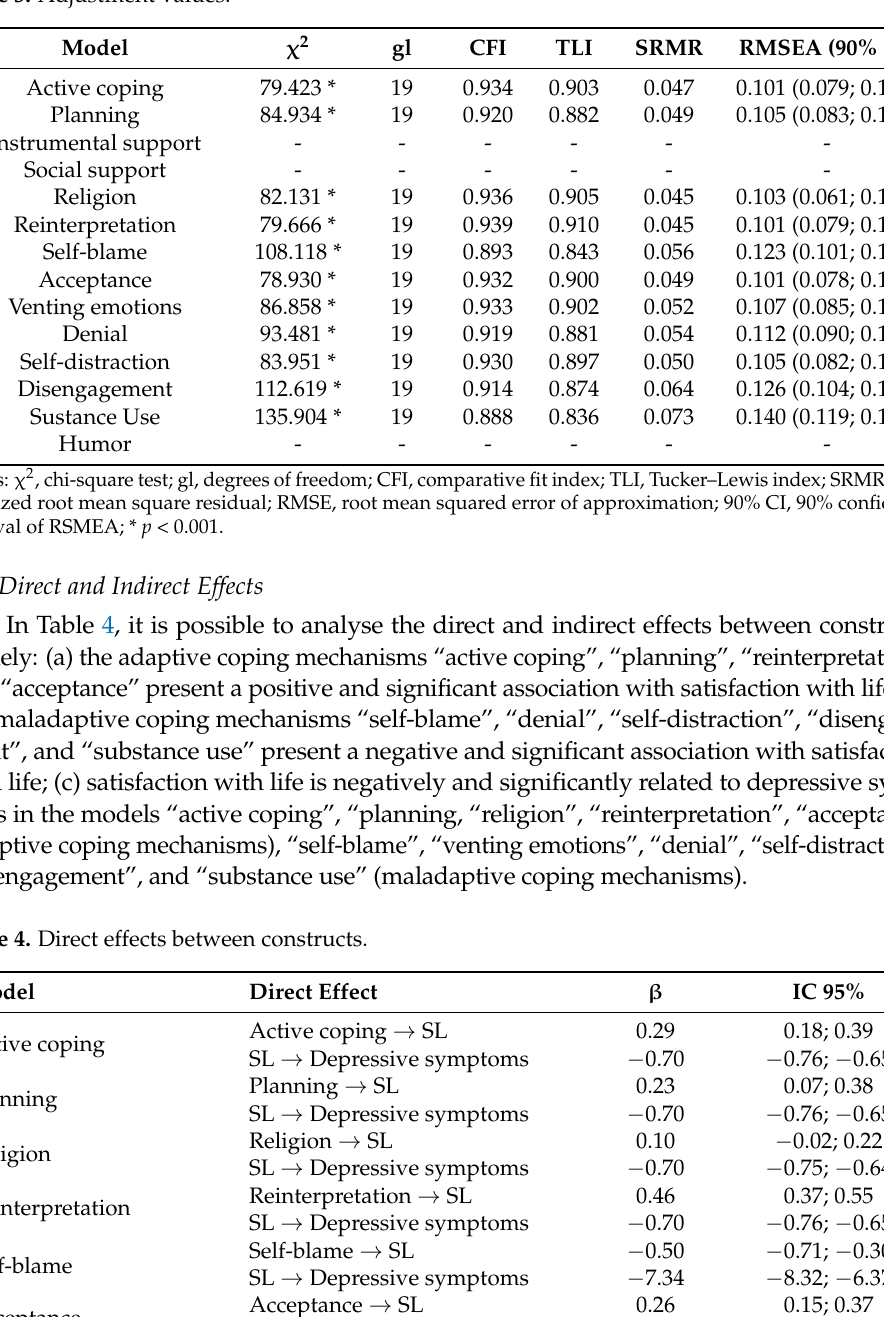
Table 3. Adjustment values.